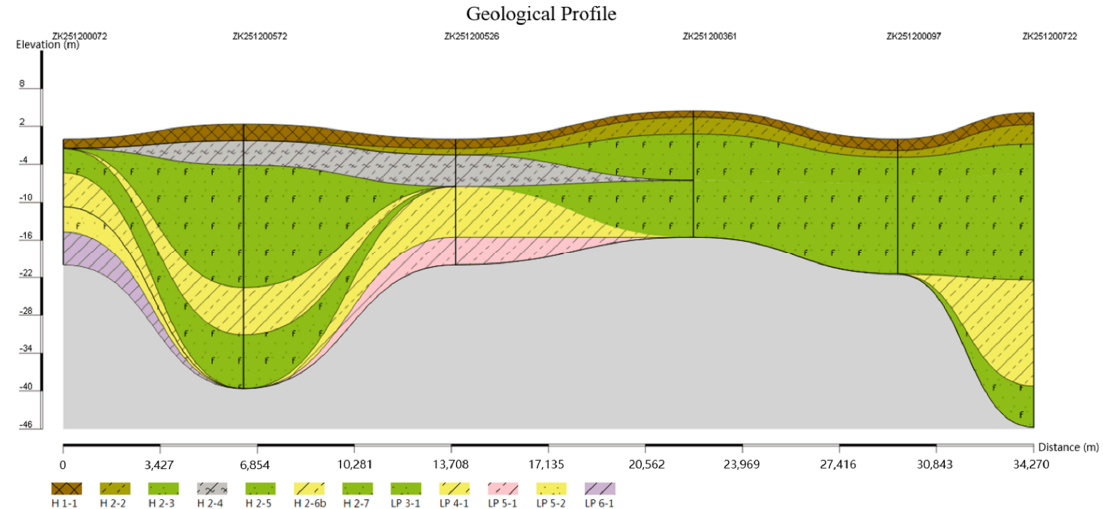
Figure 13. Geological profile VI corresponding to drilling line VI in Figure 12 by unique path method.